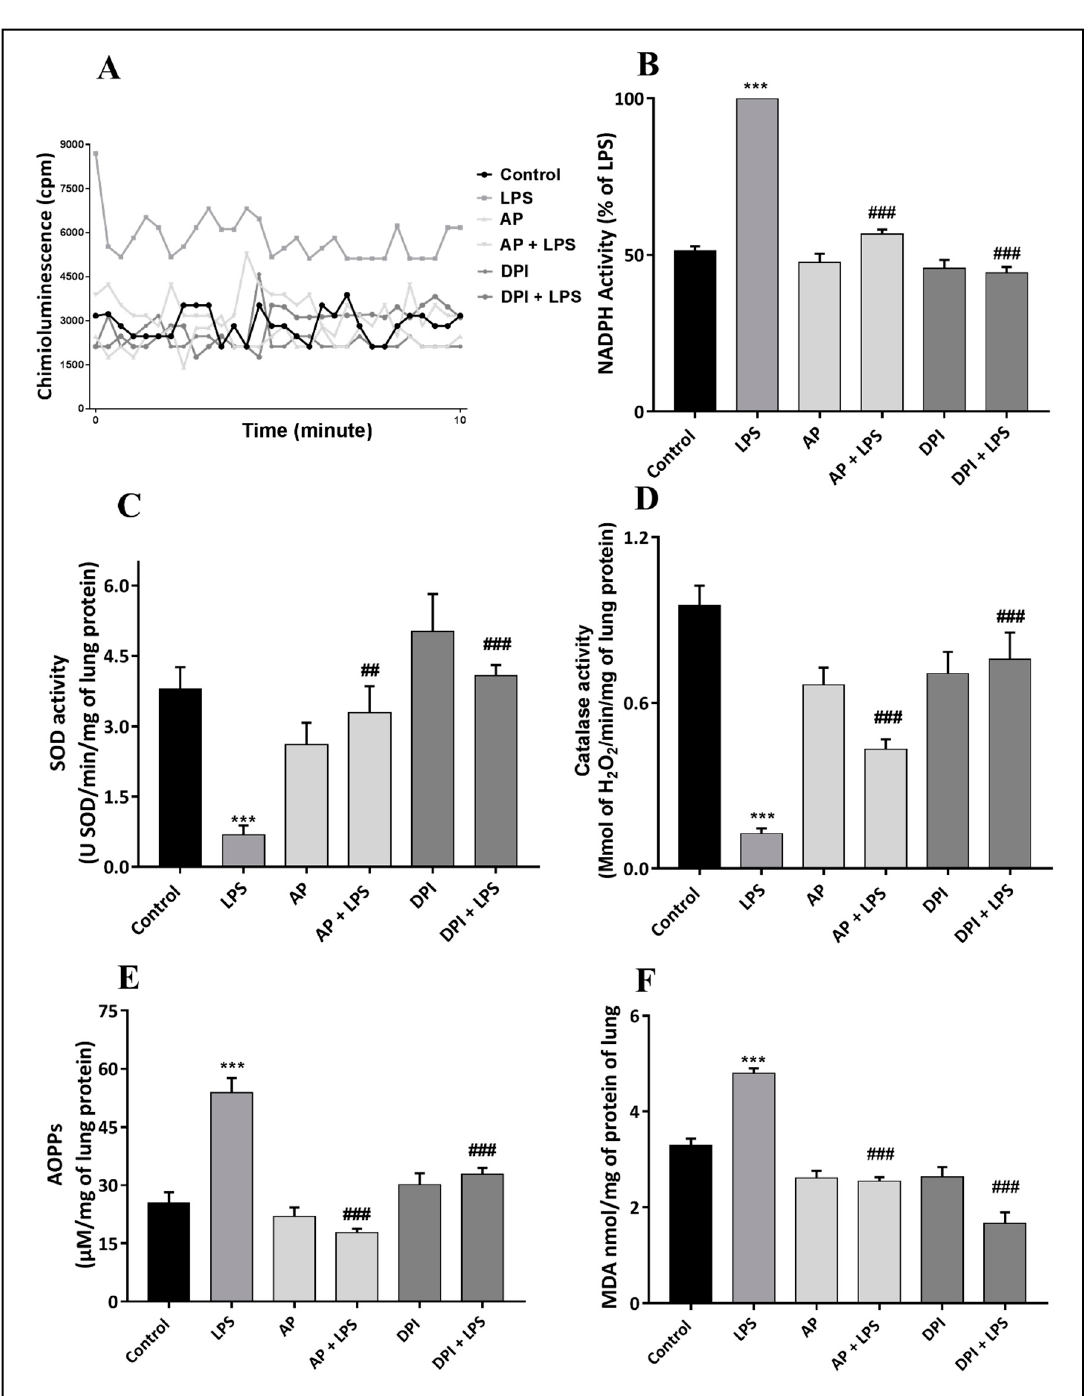
Figure 5. Effect of AP and DPI on NOX activity in lung homogenate ( A ) with data are expressed as mean ± S.E.M ( B ), SOD ( C ), catalase activity ( D ), AOPPs level ( E ), MDA ( F ) during the induction of acute lung inflammation by LPS. Data are displayed as mean ± SEM and represent at least five ( n = 5) independent experiments. *** p < 0.001 significant differences as compared to the control group, ## p < 0.001 and ### p < 0.001 significant differences as compared to the LPS group. 3.4. Apocynin and DPI Reduce LPS-Induced Increase in Mediators of Inflammation Levels in Rat Lung inflammation is characterized by neutrophils in the lungs, a major inflamma- tory parameter. Myeloperoxidase (MPO) is a specific quantifiable marker of neutrophils. To quantify this inflammatory parameter, we determined MPO activity in BAL. Results showed that LPS induced a significant increase ( p < 0.001) in MPO activity compared to